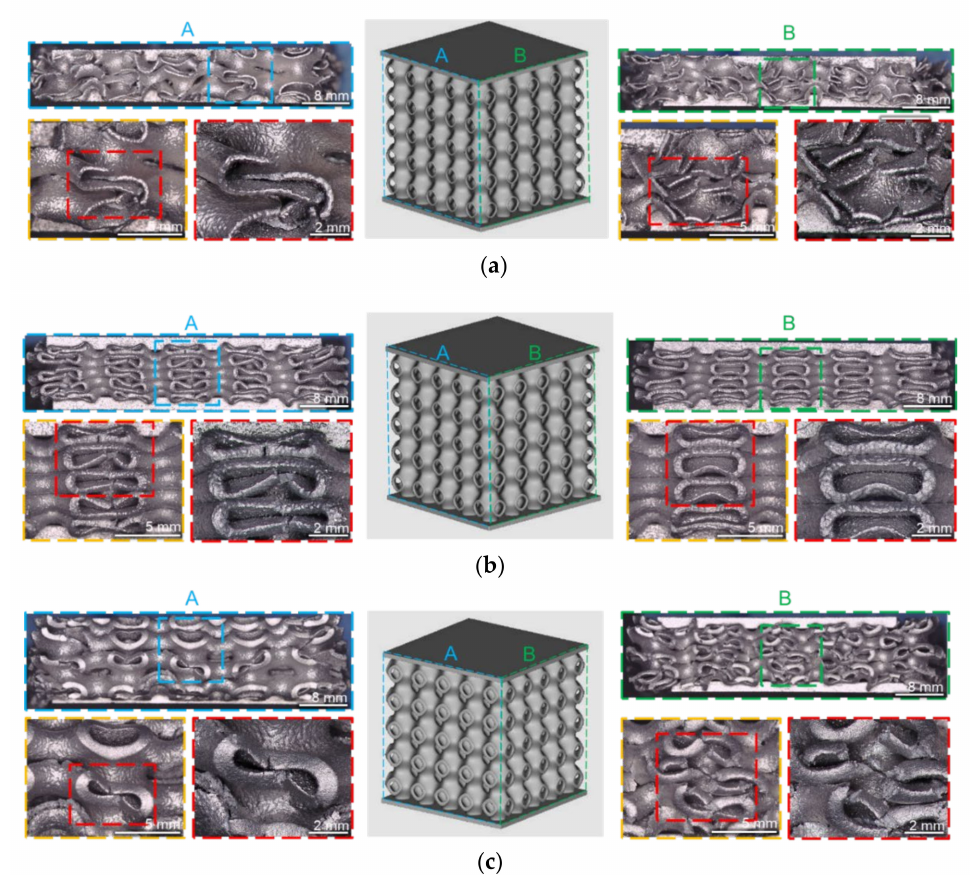
Figure 13. Failure analysis on two surfaces of the Schwarz-P TPMS structure for three different wall thicknesses/relative densities: ( a ) 0.4 mm/0.11; ( b ) 0.6 mm/0.17; ( c ) 0.8